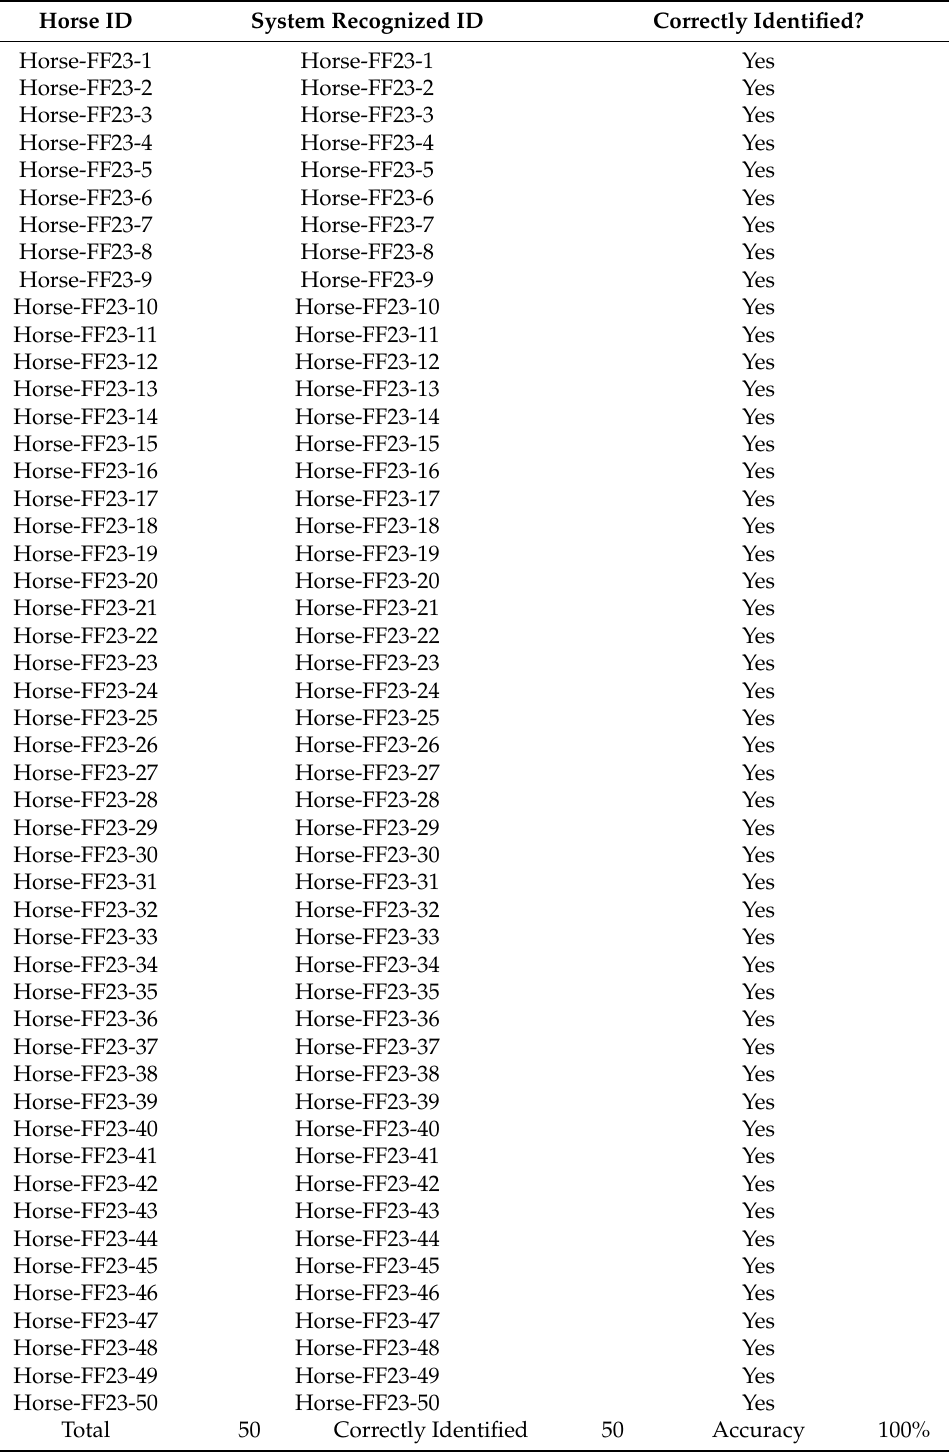
Table 5. Experiment